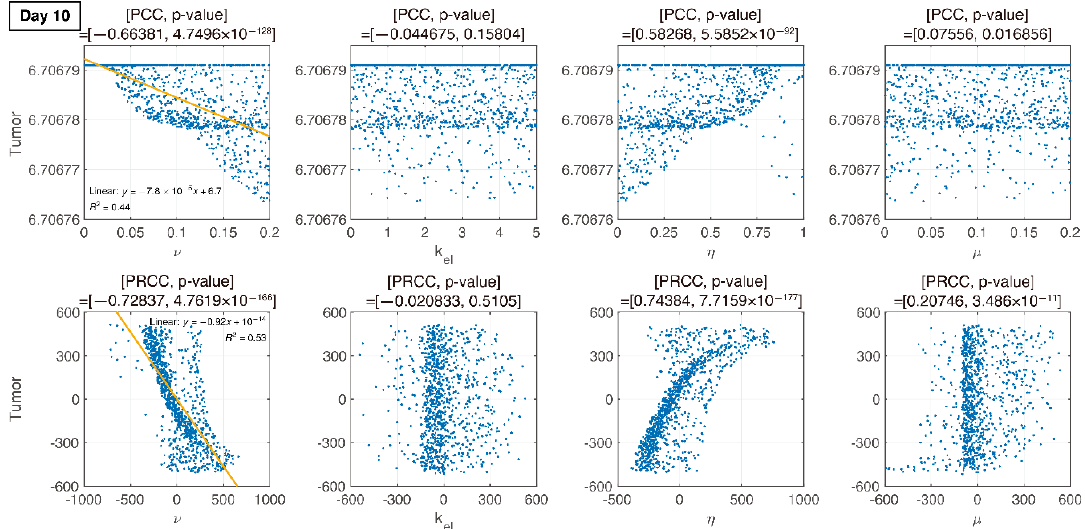
Figure 6. PCC and PRCC scatter plots of tumor size versus parameters k el , µ , ν , and η on day 10. All four parameters are varied simultaneously. The sample size is 1000. The x -axis represents the parameter values in PCC or the residuals of the linear regression between the rank-transformed values of the parameters. The y -axis represents the tumor size in PCC or the residuals of the linear regression between the rank-transformed values of tumor versus the rank-transformed values of the parameters. The title of each plot represents the PRCC value with the corresponding p -value. The linear relationship between parameters and tumor variation becomes more apparent with PRCC compared to PCC.